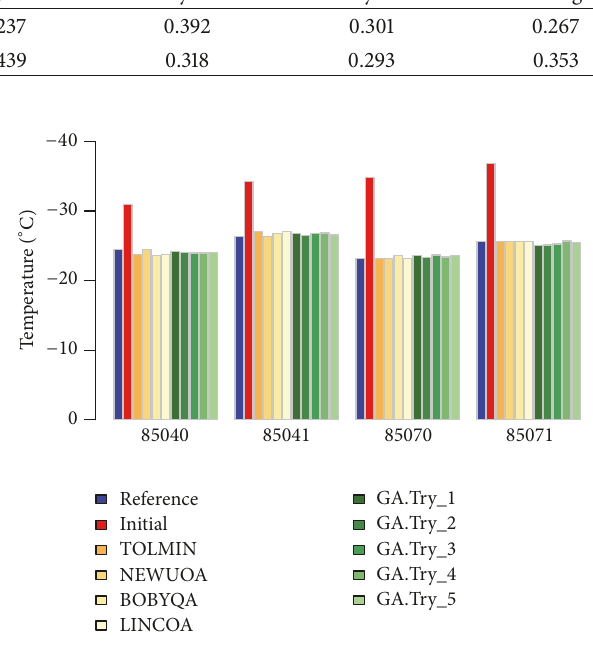
Figure 2: Steady-state hot case. Temperatures obtained from corre- lations.